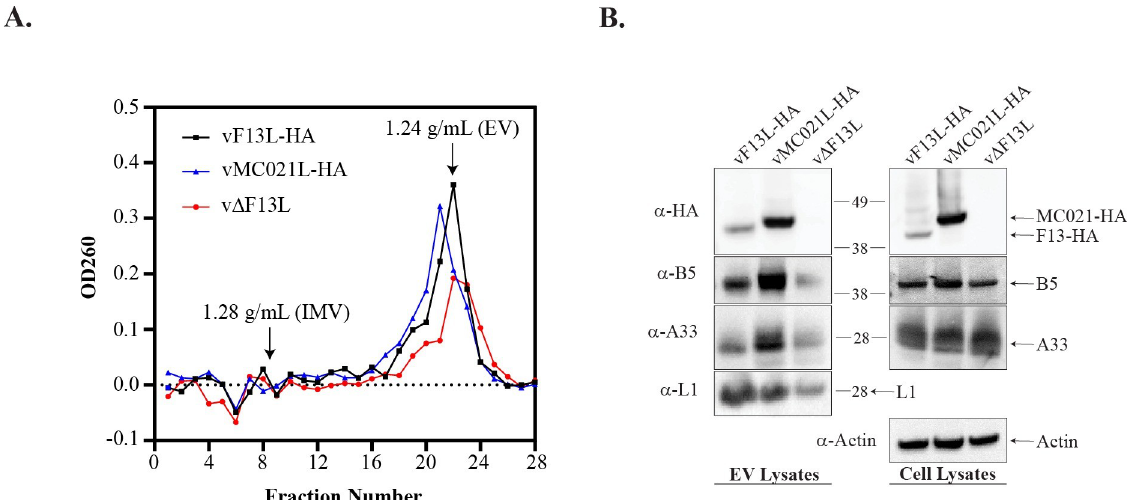
Fig 1. Glycoprotein content of EV membranes. (A) RK13 cells were infected with the indicated viruses at a MOI of 5. At 24 hpi, progeny virions released into the media (EV) were purified by CsCl density gradient centrifugation. Fractions from the gradient were collected dropwise from the bottom of the gradient and analyzed by OD260 and the concentration of CsCl determined by refractometry. (B) Fractions containing EV were collected (left) and infected cells were harvested (right) and analyzed by Western blot with rabbit anti-HA antiserum followed by HRP-conjugated donkey anti-rabbit antibody, rat anti-B5 MAb followed by Alexa Fluor 647-conjugated donkey anti-rat antibody, rabbit anti-A33 antiserum followed by HRP-conjugated donkey-anti rabbit antibody, rabbit anti-L1 antiserum followed by Alexa Fluor 647-conjugated donkey anti-rabbit antibody, and mouse anti-actin MAb followed by Alexa Fluor 647-conjugated donkey anti-mouse antibody. The masses in kilodaltons and positions of marker proteins are shown on the right of the EV lysate blot and to the left of the cell lysate